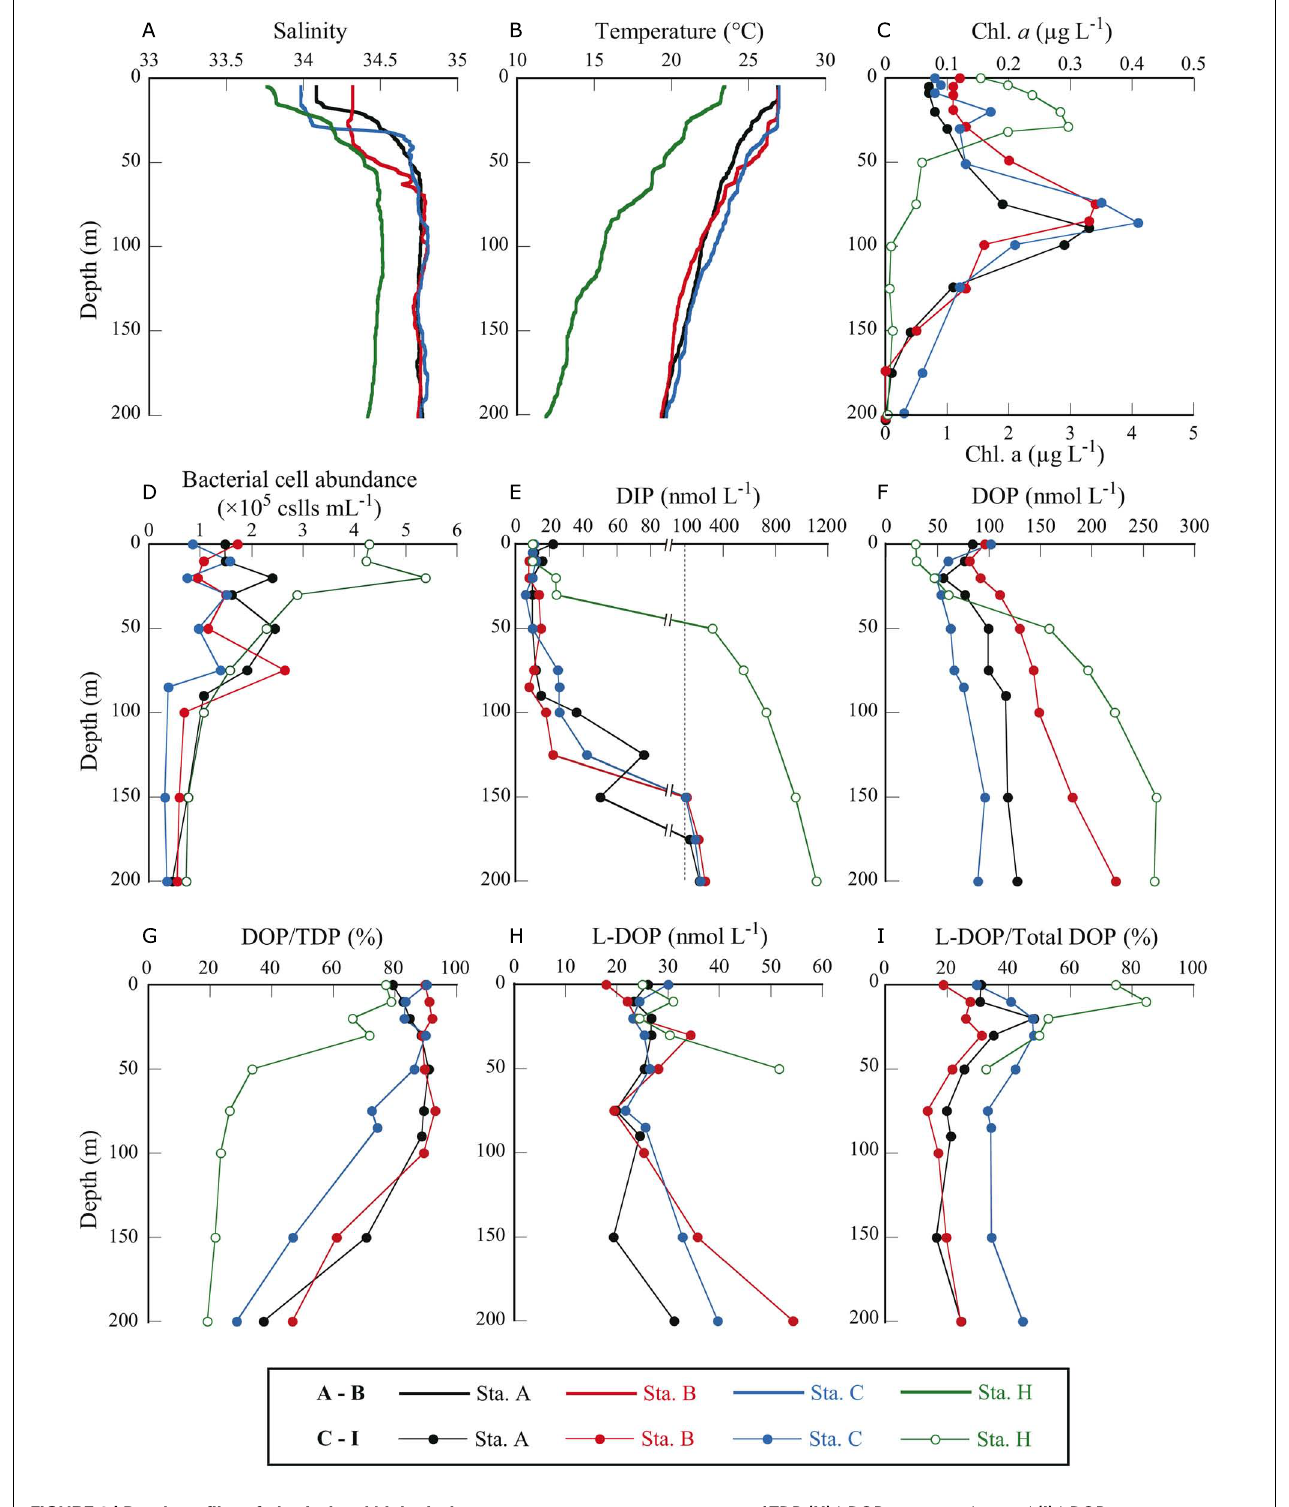
FIGURE 2 | Depth profiles of physical and biological parameters at four sampling stations in the western North Pacific Ocean. (A) salinity, (B) water temperature, (C) Chl a concentration, (D) bacterial cell abundance, (E) DIP concentration, (F) DOP concentration, (G) DOP as a